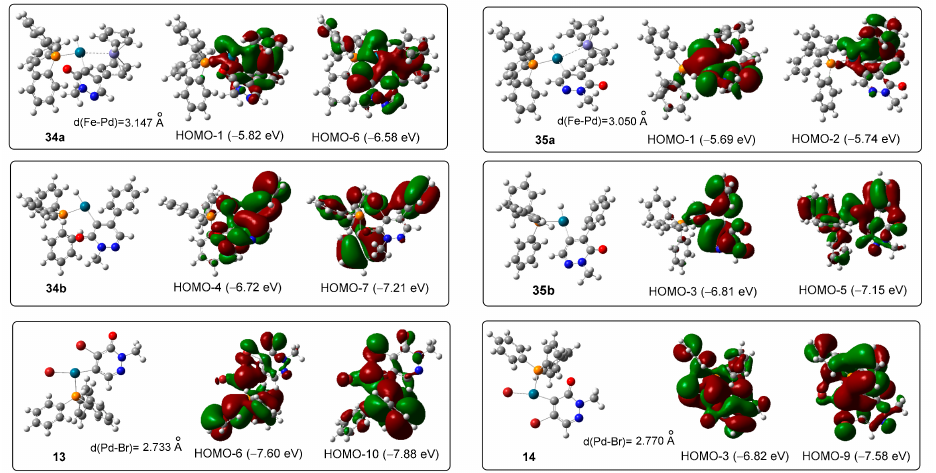
Figure 4. The identified sets of delocalized MOs indicating Fe–Pd interaction in ferrocene-containing complex isomer pair 34a + 32 / 35a + 32 , phenyl–Pd coordination interaction in phenyl-substituted complex isomer pair 34b + 32 / 35b + 32 , and Br–Pd interaction in bromo-substituted isomer pair 13 / 14